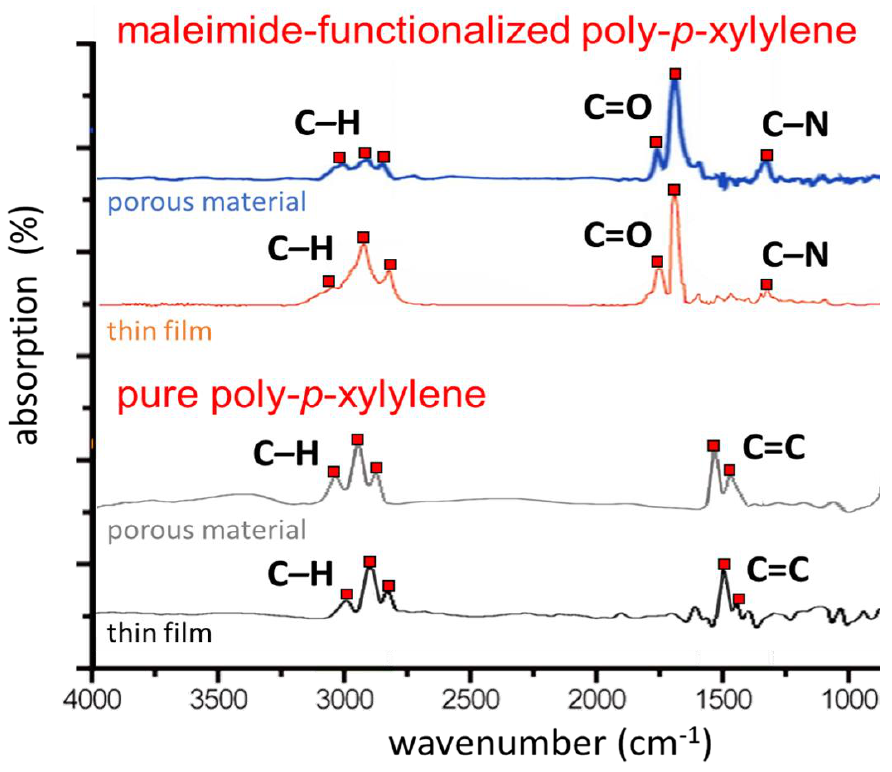
Figure 4. Fourier transform infrared (FT-IR) analysis showed consistent spectra. Characteristic peaks of the maleimide-functionalized poly- p -xylylene were detected for C-H, C=O, and C-N on the fabricated porous materials. The results were compared to a thin-film maleimide-functionalized poly -p- xylylene and pure (non-functionalized) poly -p- xylylenes.